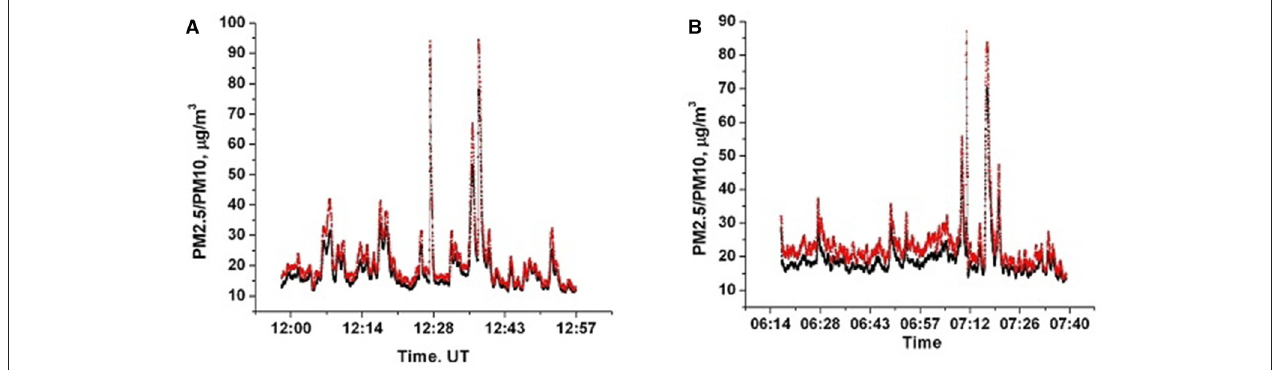
FIGURE 13 | Continuous recording of PM2.5 (black) and PM10 (red) measurements along Kyiv city roads. Spikes correspond to high-level contamination in (A) central part of the city and road intersections; (B) ring road around the city and entry road.